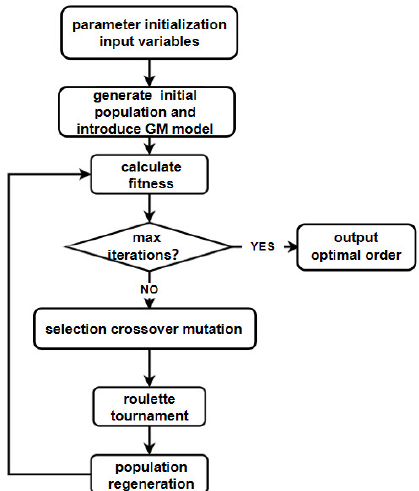
Figure 3. Flowchart of optimal order determination of fractional order grey accumulation model based on genetic algorithm.